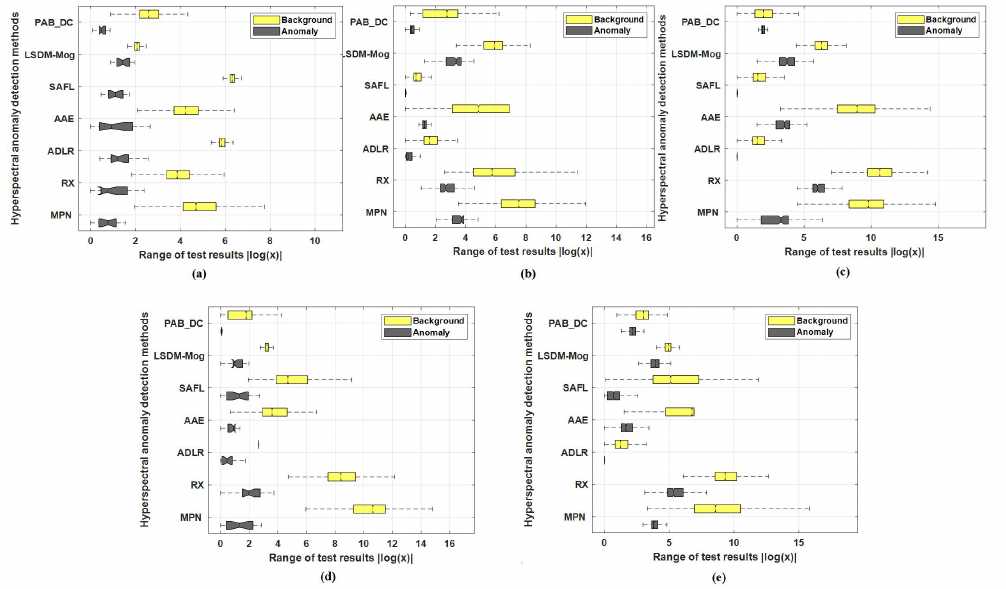
Figure 5. The separability analysis of different methods for ( a ) HYDICE, ( b ) ABU-urban1, ( c ) ABU- urban2, ( d ) Grand Island, ( e ) EI Segundo. The larger the distance, the more obvious